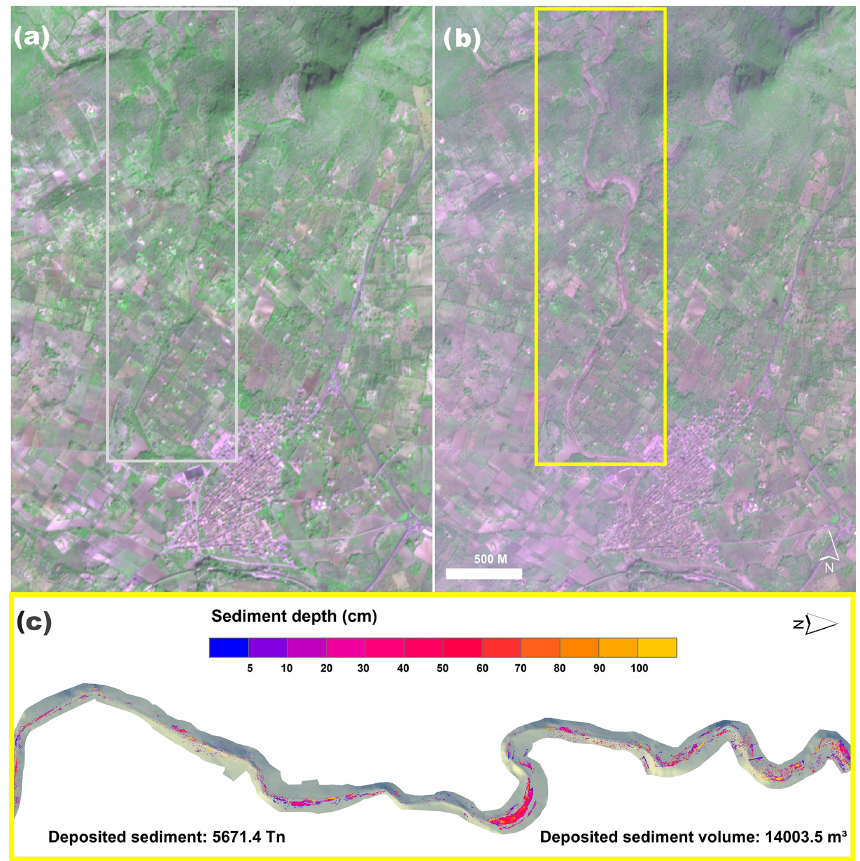
Figure 8. Effects of the catastrophic flash flood on the agricultural surroundings of Sant Llorenç town: sharpened false infrared RGB composites before, on 9 October (a) , and after, on 11 October (b) , the event derived from Planet ® high-resolution (3m) imagery; (c) spatial patterns of sediment deposition and